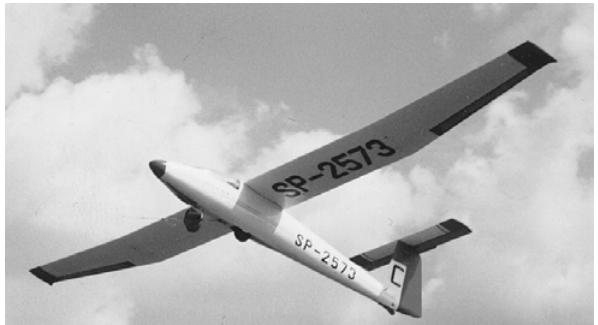
Fig 7. SZD-30 sailplane towed by the